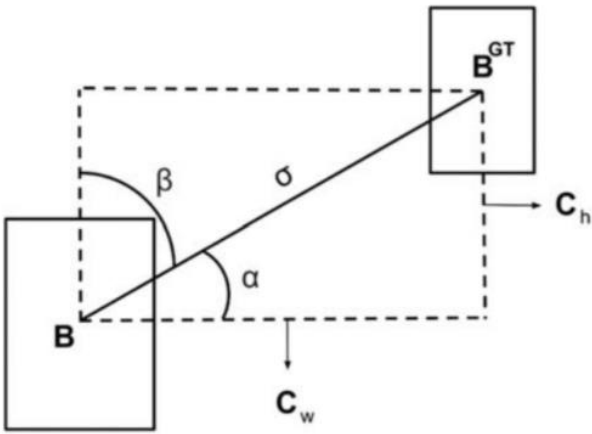
Figure 12. SIoU schematic.